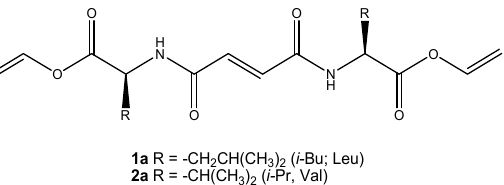
Figure 1. Chemical structure of bis(amino acid)formamide vinyl esters organogelators.